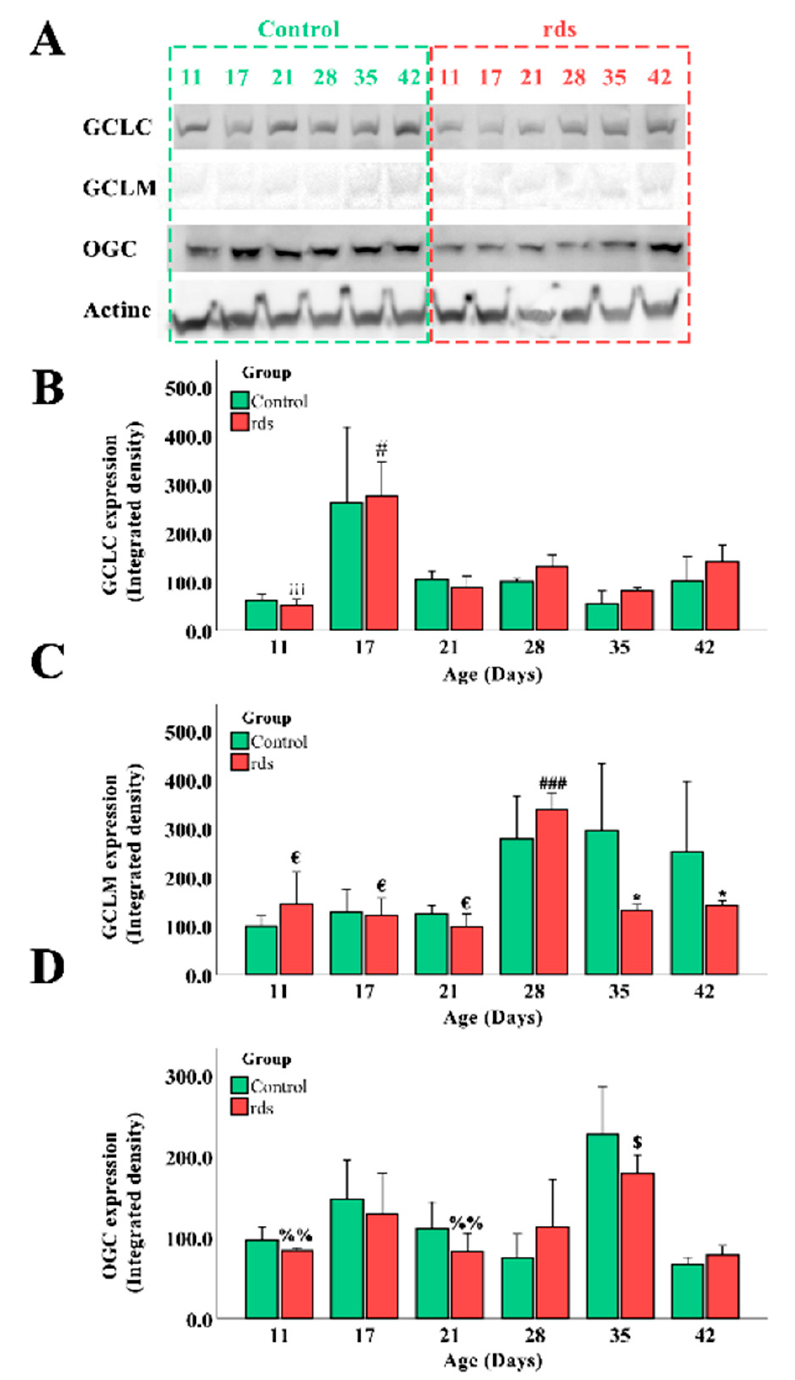
Figure 7. Alteration in proteins involved in GSH metabolism and regeneration. ( A ) GCLC, GCLM, OGC, and Actin expression in retinas of control and rds mice at PN11, PN17, PN21, PN28, PN35, and PN42 (Image Quant™TL photos) (four mice were used per group and both retinas of each mouse were collected and homogenized together). ( B ) GCLC expression in control and rds mice at different postnatal ages (# p < 0.0001 vs. rds PN21, PN28, PN35, and PN42; ¡¡¡ p < 0.0001 vs. rds PN17). ( C ) GCLM expression in control and rds mice at different postnatal ages (* p < 0.05 vs. control group at the same age; € p < 0.0001 vs. rds PN28; ### p < 0.0001 vs. rds PN35 and PN42). ( D ) OGC expression in control and rds mice at several postnatal ages (%% p < 0.0001 vs. rds PN35; $ p < 0.0001 vs. rds PN42).